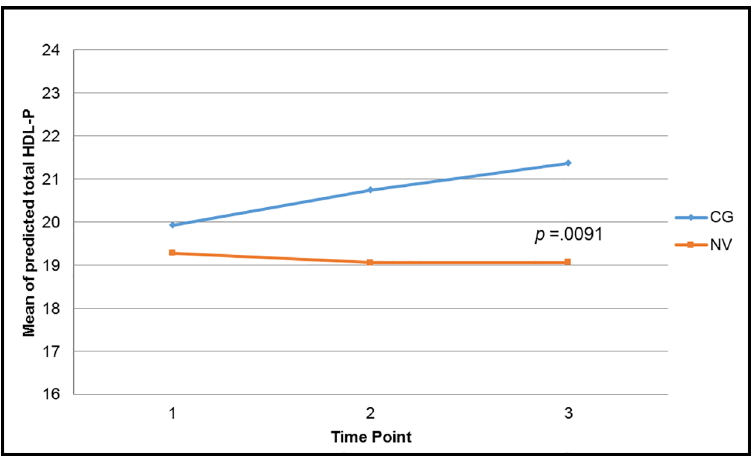
Fig 2. Predicted total HDL-P particle concentration over time based on caregiverstatus, controlling for income. Contrast tests showedsignificantdifferences betweentime-point3 and time-point 1 for caregiver group only ( p = .0017). CG caregiver, NV normal